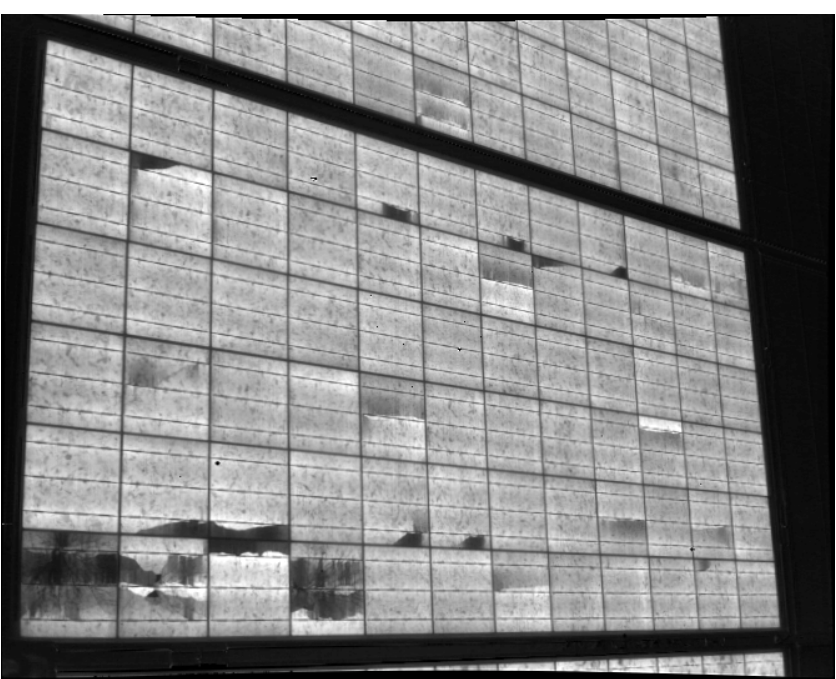
Figure A3. DaySy ™ electroluminescence (EL) image after distortion correction. Straight line struc- tures in the PV module are represented by straight line structures in the image.